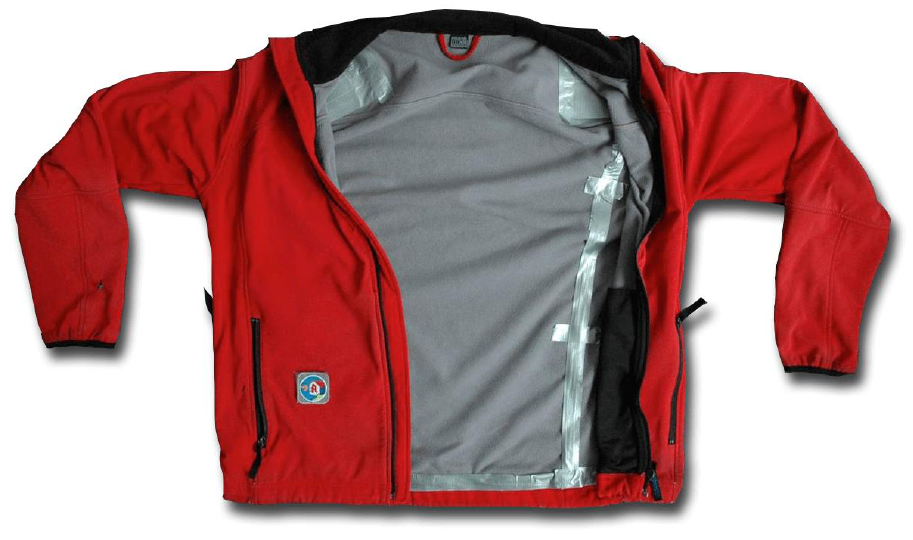
Figure 5. Smart jacket prototype.